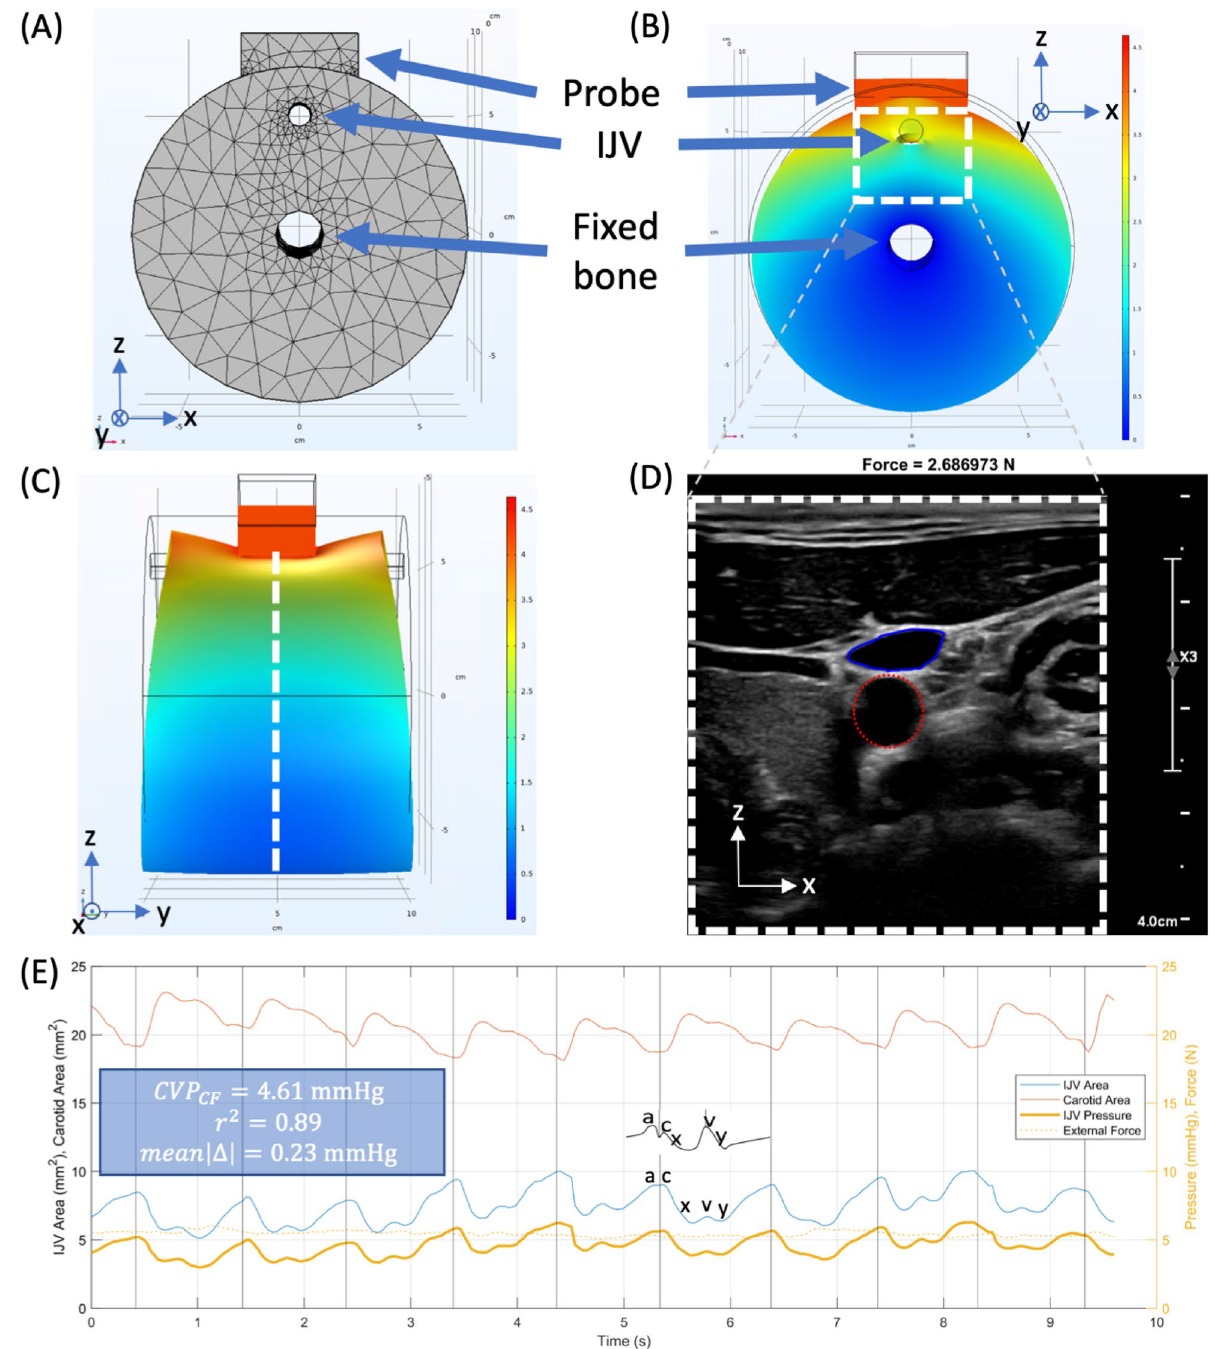
Figure 4. ( A ) 3-D finite element model mesh of the IJV passing through the neck and the force-coupled ultrasound probe contacting the surface of the skin above it. ( B ) 3-D finite element forward model Euclidean displacement (x–z view). The dashed white box is analogous to ultrasound imaging window. ( C ) 3-D finite element forward model Euclidean displacement (y–z view). The dashed white line signifies the ultrasound imaging x–z plane. ( D ) 2-D ultrasound image of segmented IJV (solid blue) and carotid artery (dashed red) short-axis cross-sections for subject 20. ( E ) IJV area, carotid area, IJV pressure estimation, and force plot at an almost constant external force for subject 20. The scalar venous pressure estimate from collapse force is shown with correlation and error data of collapse force and JVP. Black vertical lines symbolize visually-assessed end-diastole from the ultrasound images. A reference central venous pressure waveform from catheterization is overlaid from Tansey et al. 30 . Components of the right atrial pressure waveform reflected in the IJV area waveform are labeled. a: Right atrium (RA) pumps into right ventricle (RV). c: Tricuspid valve closes at systolic onset. x: RA relaxes and tricuspid valve move down. v: RA passively fills; tricuspid opens. y: RA passively empties before